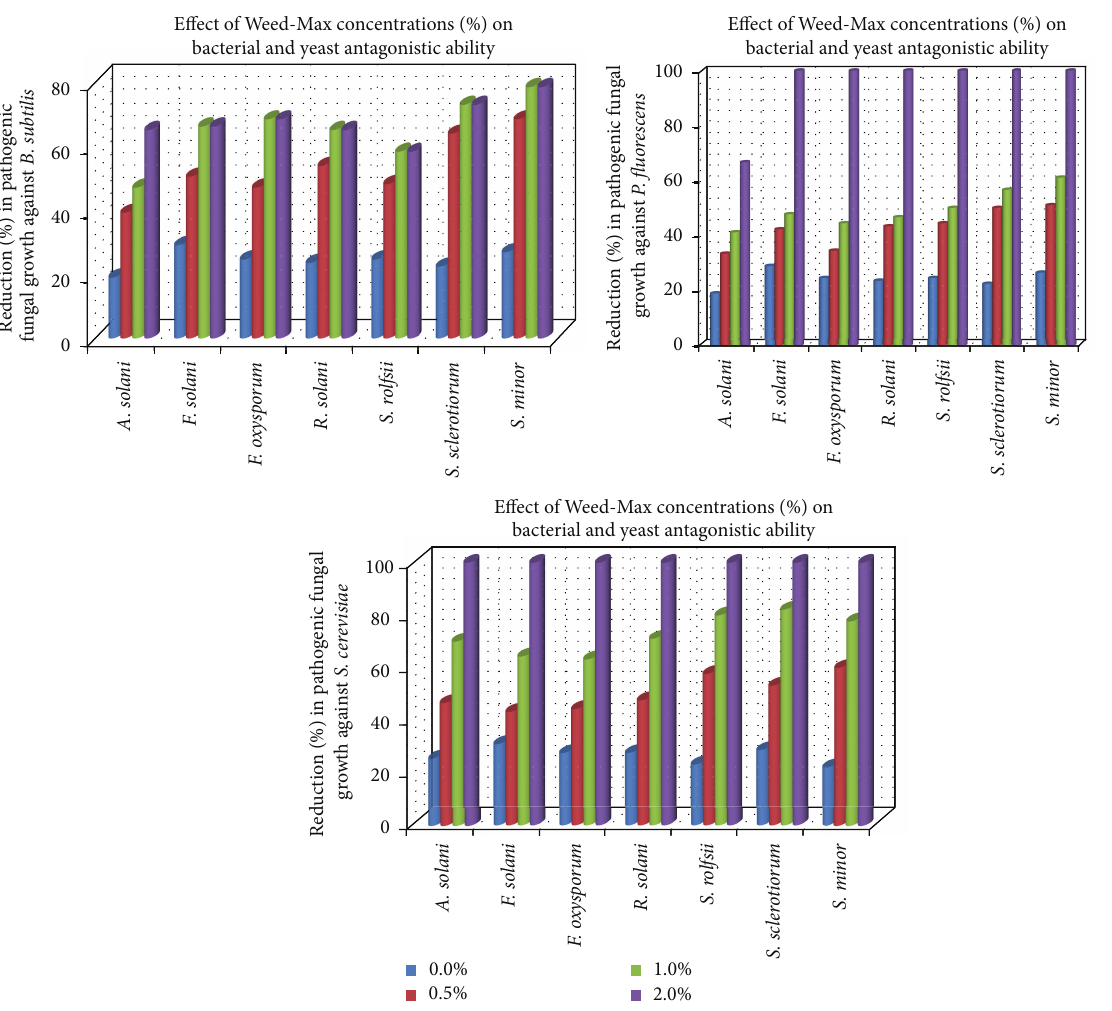
Figure 3: Reduction (%) in pathogenic fungal growth against bacteria and yeast in medium supplemented with Weed-Max at different concentrations in